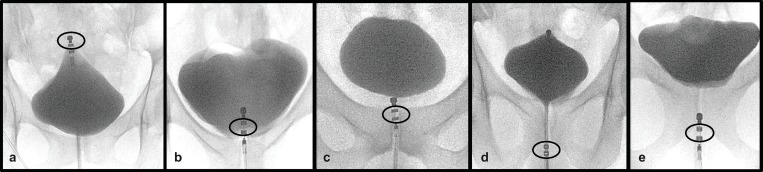
Fluoroscopic images for catheter positioning at different stimulation locations.Examples of fluoroscopic images taken after catheter positioning at the five specific stimulation locations: Bladder dome (BD, 2a), trigone (TG, 2b), proximal urethra (pUR, 2c), membranous urethra (mUR, 2d), distal urethra (dUR, 2e). Bladder volume was 60mL of contrast medium. Radiographs 2a, 2b, and 2e show positioning of the catheter for stimulation in female lower urinary tract (LUT), while 2c and 2d represent images of the catheter in male LUT. The stimulating electrodes are encircled in black.